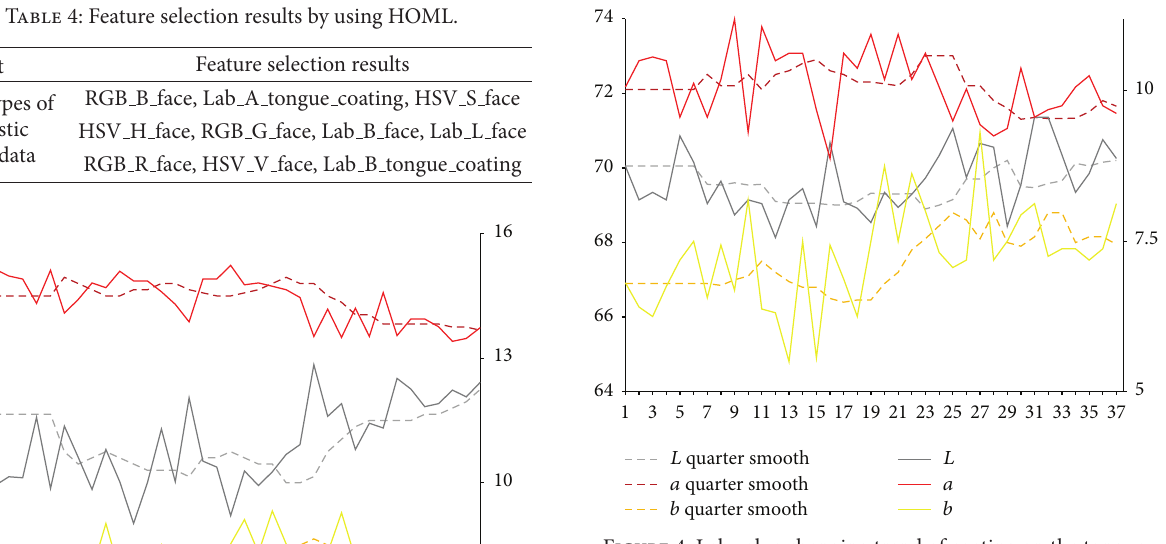
Figure 4: Lab value changing trend of coating on the